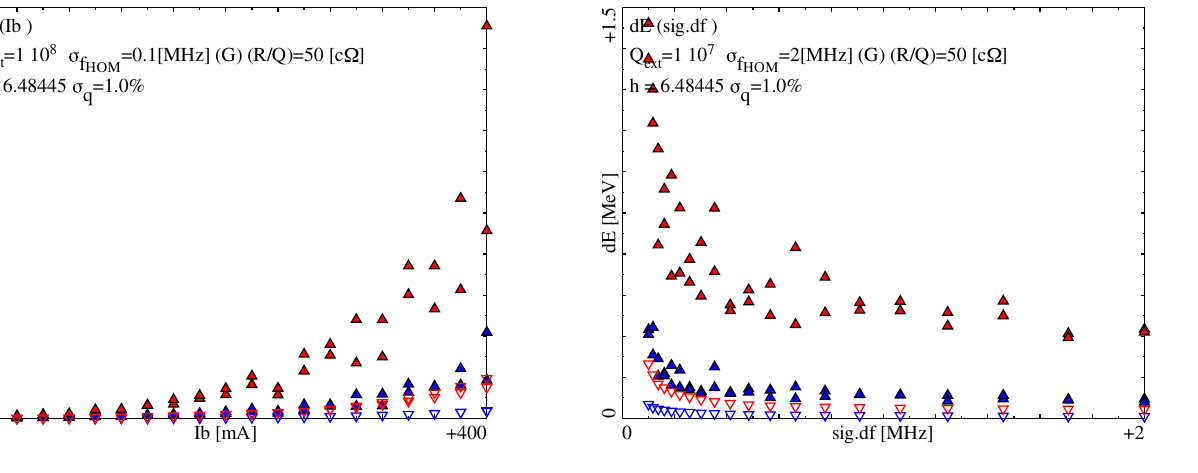
FIG. 31. (Color) dE as a function of (cid:1) (cid:3) f for two consecutive pulses with Q ext ¼ 10 7 , I b ¼ 400 mA ; red: worst bunch in pulse; blue: rms; filled upward triangles: with 1% charge scatter; hollow downward triangles: without bunch noise.